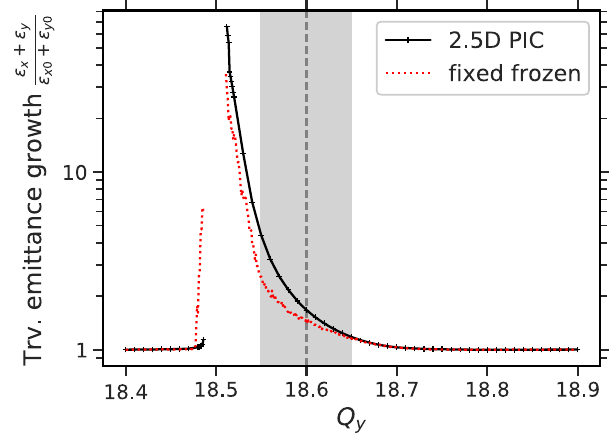
width.FIG. 4. Tracking results without space charge for final rms beam sizes vs vertical tunes around the quadrupole resonance Q ¼ 18 . 5 at fixed Q ¼ 18 . 75 . Dotted line: beam-loss curve for y x separate simulations including